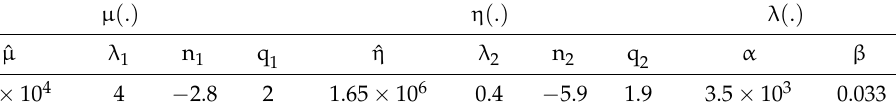
Figure 16. Flowchart used for the inverse identification procedure. Table 2. Inverse identification results.